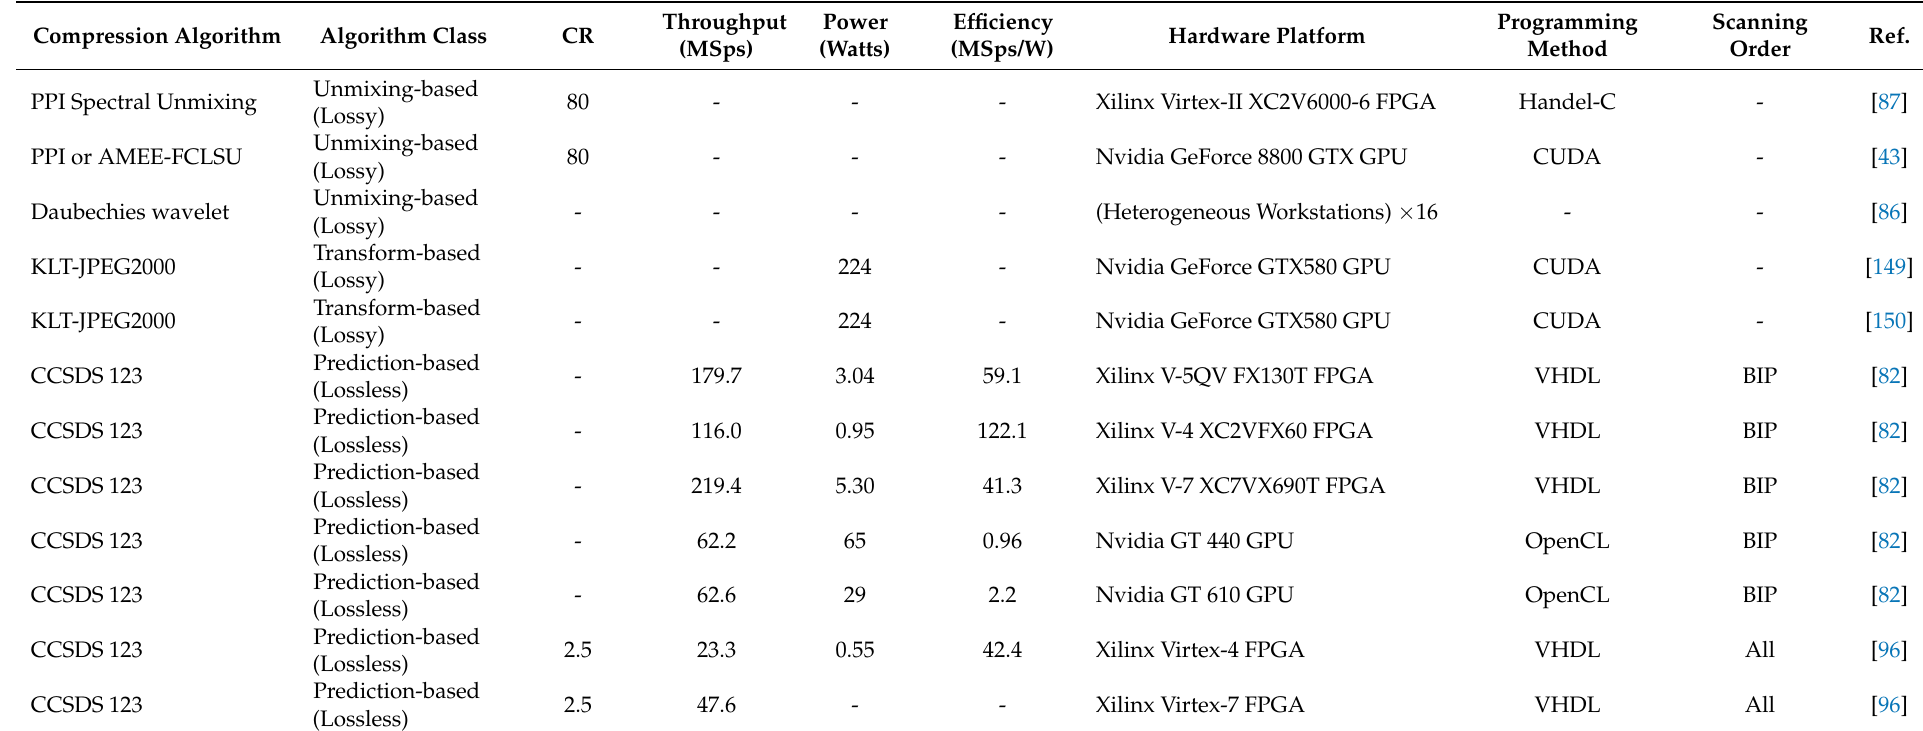
Table 13. Comparison of the proposed compression system validated using the AVIRIS World Trade Center